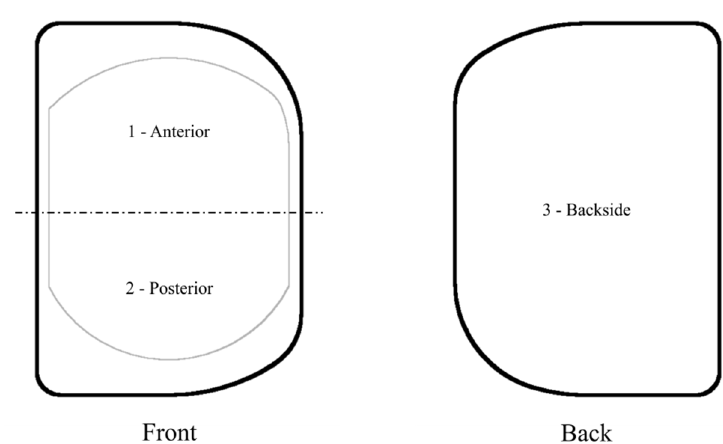
Figure 1. The front and back of the meniscal bearings were divided into three sections. Surface damage grading scores were assigned for each section using light stereoscopic examination and a subjective grading score.